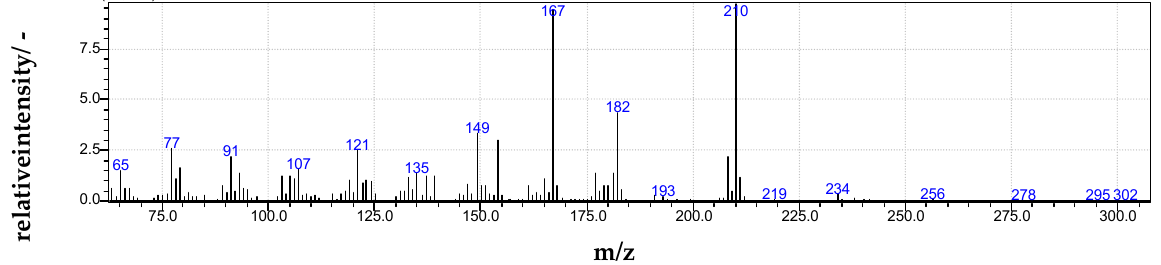
Figure 7. Mass spectrum of the initial unidentified peak fragment on the chromatogram of P.tremula extract with a retention time of 26.82.